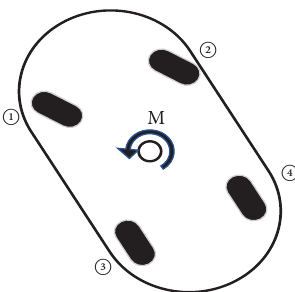
Figure 4: Car steering